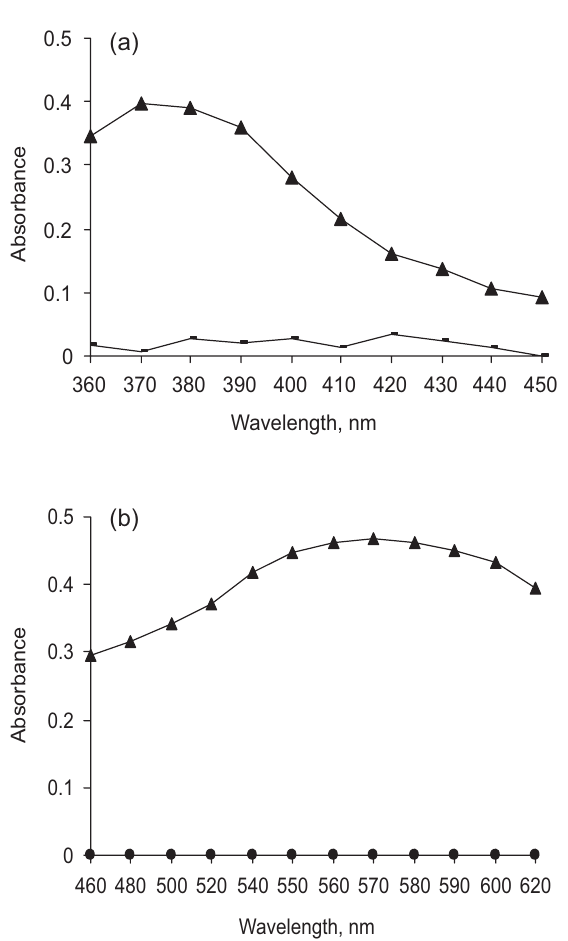
FIGURE 2- (a) Absorption spectra of DEC-iodide complex (  ) [20 m g mL -1 DEC] and blank (-); (b) Absorption spectra of DEC- iodine-starch complex (  ) [20 m g mL -1 DEC] and blank ( 